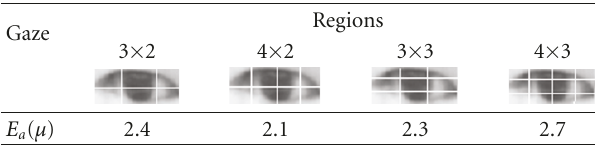
Figure 9: The distribution of eye samples corresponding to the di ff erent gaze directions. Table 2: Errors of di ff erent regions (degree).